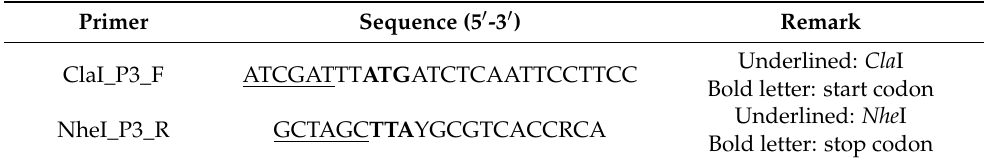
Table 3. Sequences of primers used for cloning P3 ORF of FMDV